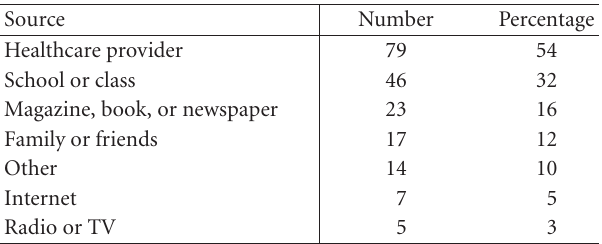
Table 4: Source of CMV awareness or knowledge. Note that mul- tiple answers were accepted so the percentages add to more than